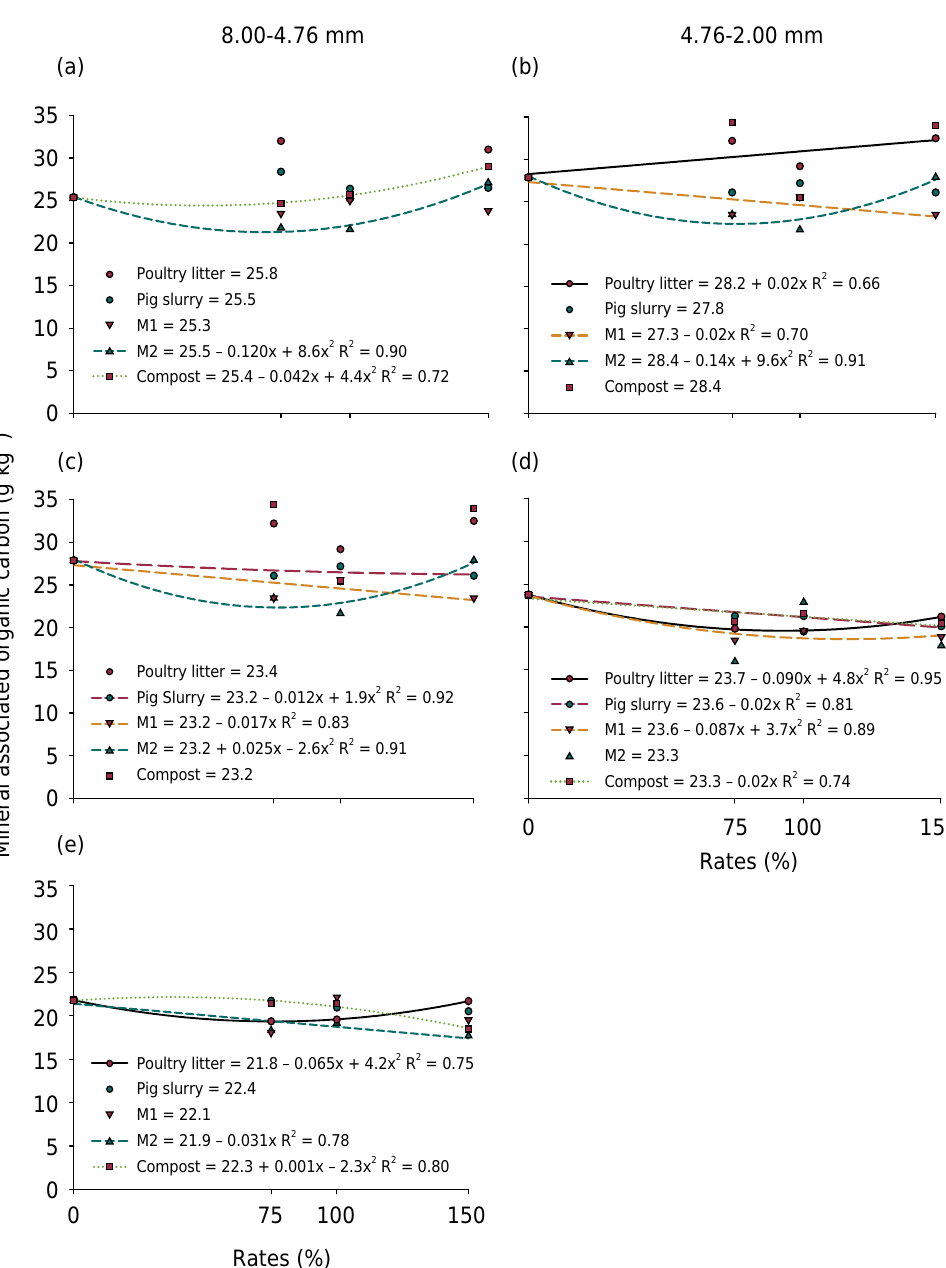
Figure 6. Mineral-associated organic carbon (g kg -1 ) from 8-4.76 mm and 4.76-2 mm aggregates from Rhodic Kandiudox. (a,b) 0.00-0.05 m soil layer; (c,d) 0.05-0.10 m soil layer; and (e) 0.10-0.20 m soil layer. M1: mineral fertilizer 1, equivalent to pig slurry; M2: mineral fertilizer 2, equivalent to poultry